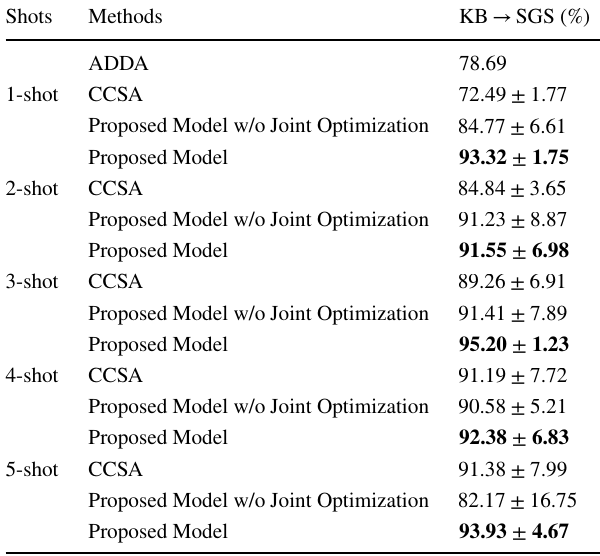
Table 3 Ablation study of the proposed method Shots